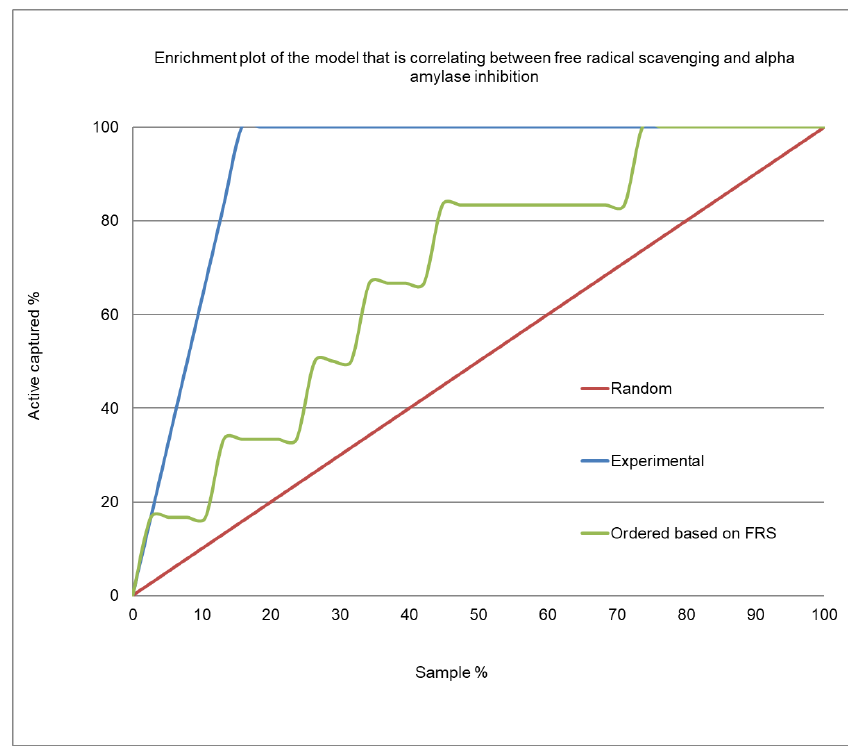
Figure 4. Enrichment plot of the prediction model for α-amylase inhibition by the plant extracts, based on their FRSA.